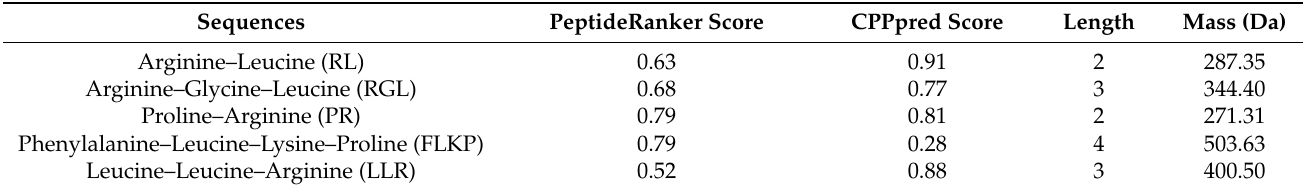
Table 3. Identification of peptides in the fraction S4.